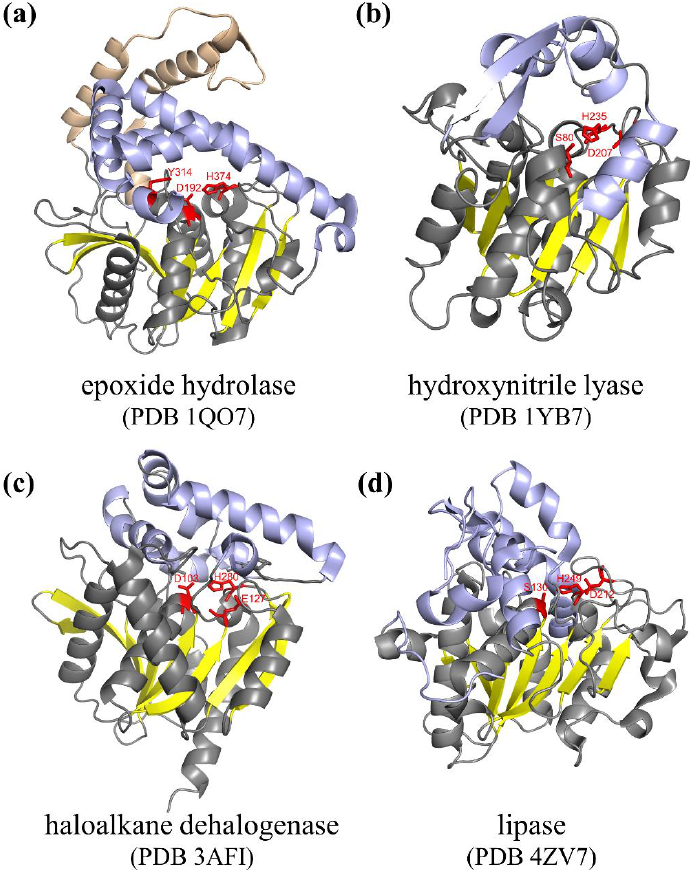
Figure 1. Structures of α / β hydrolases. ( a ) Aspergillus niger epoxide hydrolase [22]. ( b ) Hevea brasiliensis hydroxynitrile lyase [23]. ( c ) haloalkane dehalogenase DbjA [24]. ( d ) Candida antarctica lipase B [25]. The central β -sheet, flank helices, the cap domain, and the N-terminal meander are shown in yellow, gray, slateblue, and brown, respectively. The active site residues are shown as red sticks.